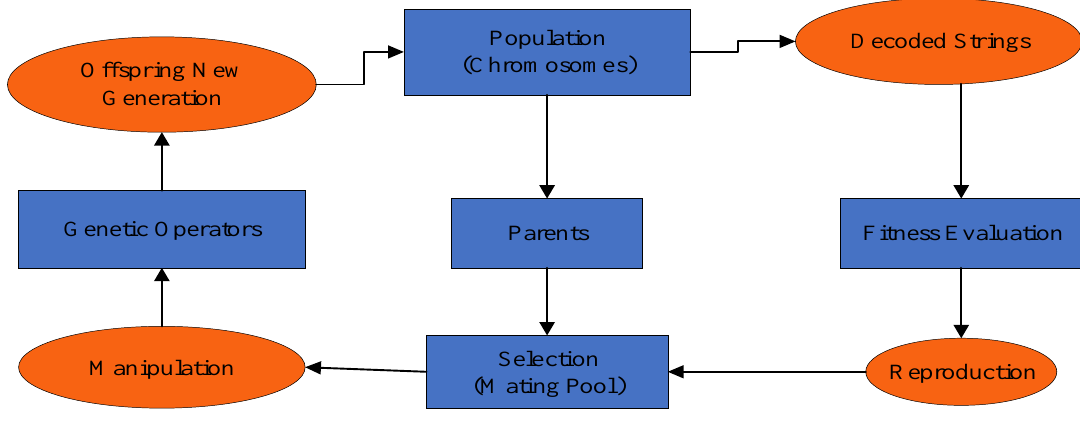
Figure 3. Genetic algorithm architecture.